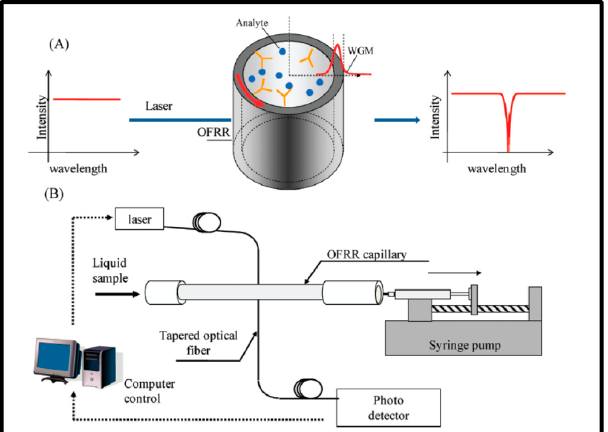
Figure 11. Schematic shows the surface functionalization of OFRR for detecting CA15-3; the system